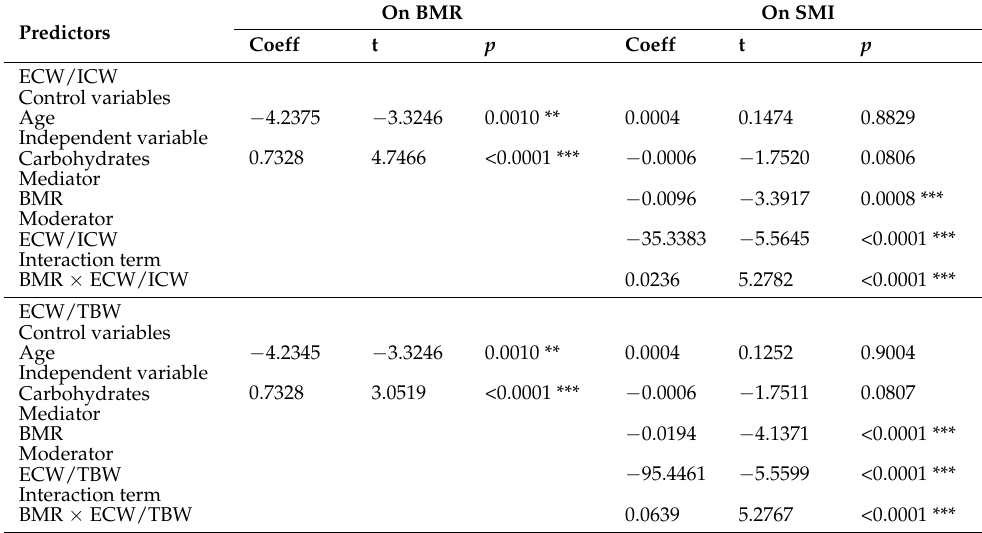
Figure 3. The moderating effects of BMR and body water distribution on SMI. ( a ) ECW/ICW; ( b ) ECW/TBW. Table 4. Moderated mediation effect analysis.